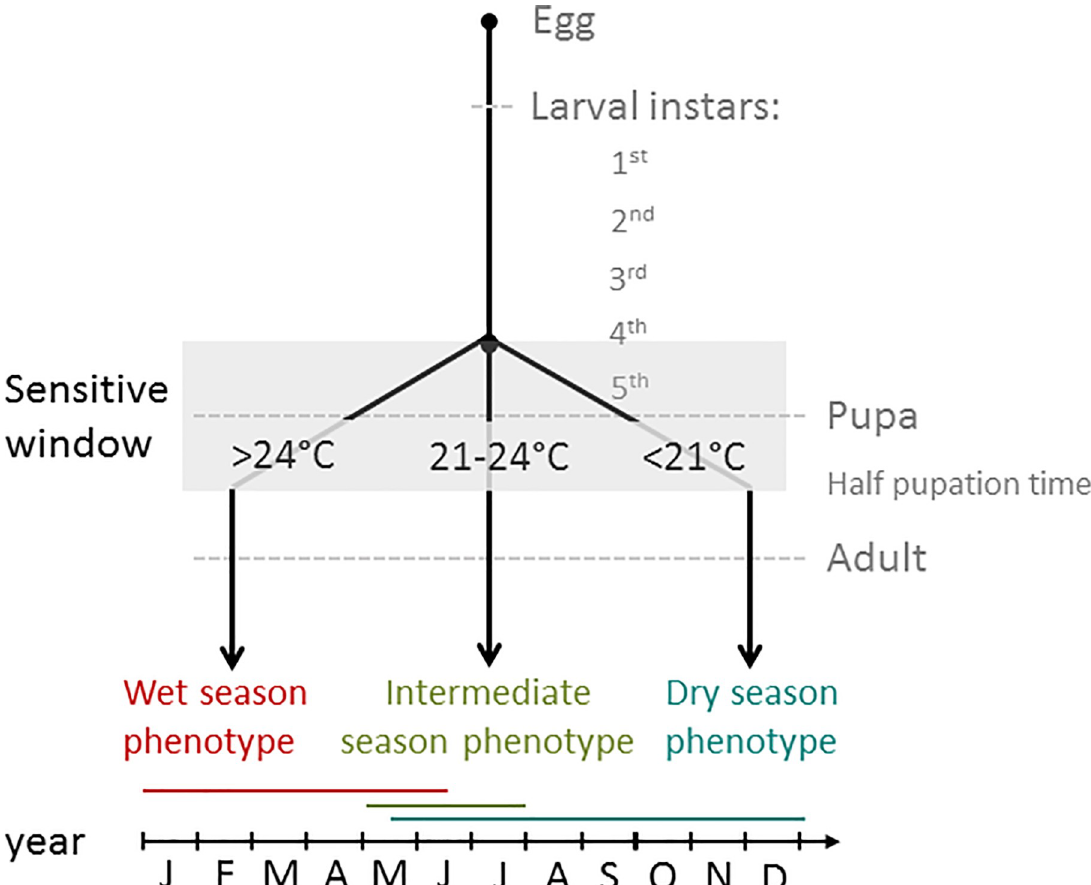
Fig 1. Temperature ranges leading to the production of wet, intermediate and dry season forms and their occurrence across the year in Malawi [7,19]. Seasonal forms occurrence and changes throughout season may vary according to specific climatic conditions in other parts of the species distribution area [24]. Red, green and blue lines show when WS, IS and DS forms are found in the field in Malawi, respectively. There is no data about the IS presence in the field at other times of the